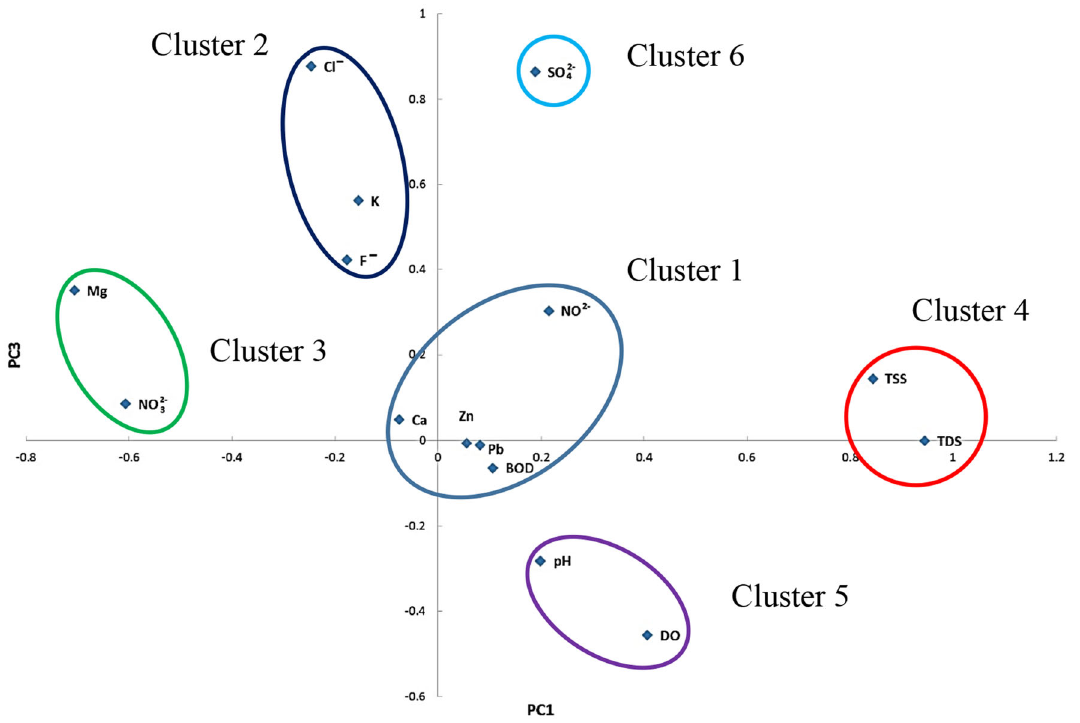
Fig. 3 Plots of PC1 vs. PC3 showing all analyzed